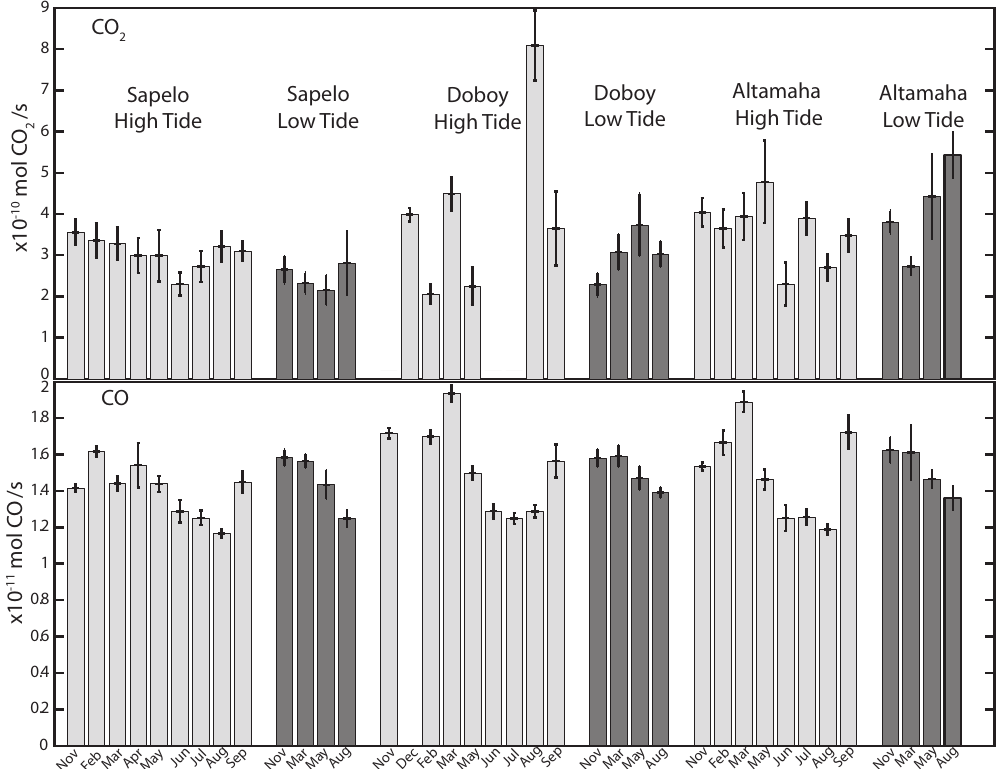
Fig. 3. CDOM normalized production for CO 2 and CO. Error bars represent standard error of